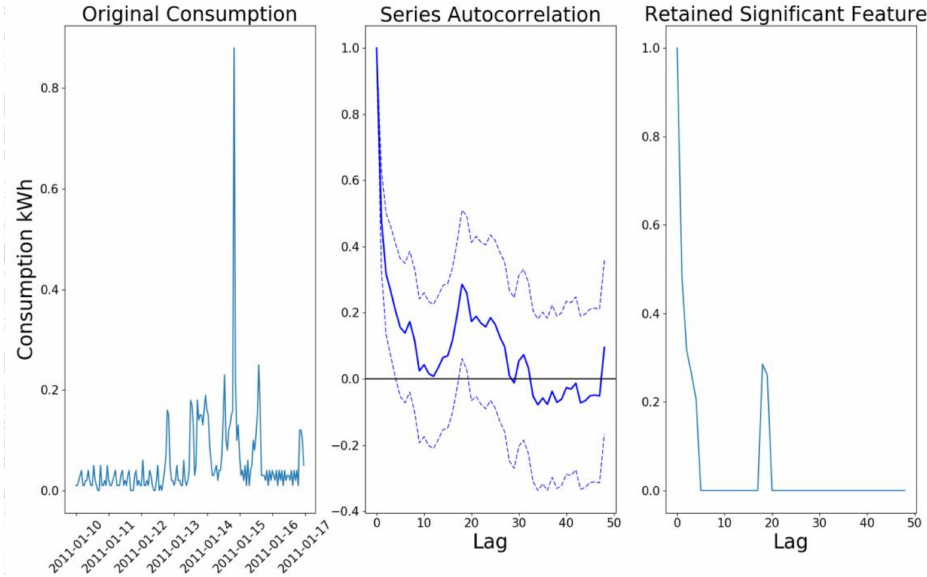
Figure 5. ( Left ) The original consumption profile, ( Middle ) the solid line is the autocorrelation coefficient, dashed lines are the 95% confidence intervals. ( Right ) Significant autocorrelation coefficients retained as meter features and applied as input to K-Means clustering. The significant lags include lags from the first five lags and a recurrence at around lag 20, indicating some periodicity in the